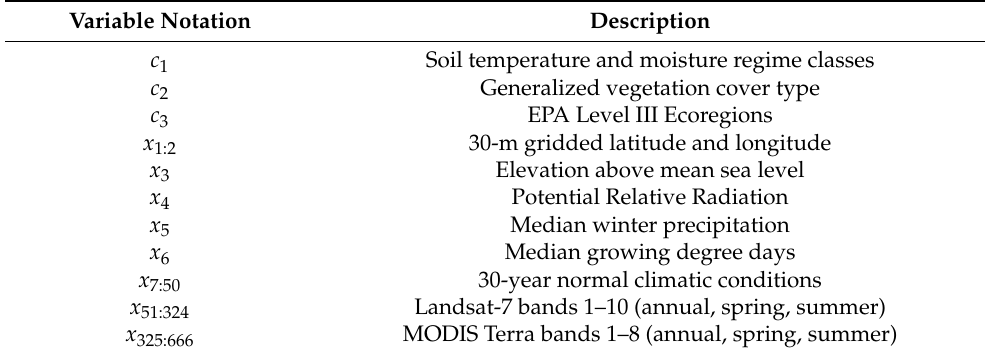
Table 2. Categorical ( c i ) and continuous ( x i ) biophysical, ancillary, and spectral predictor variables included in variable